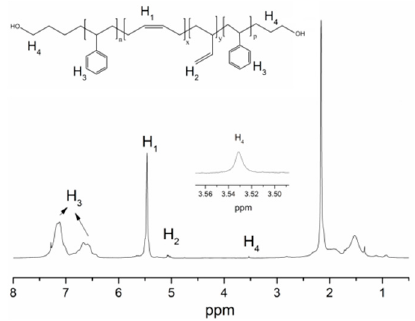
Figure 1. 1 H-NMR of HO–SBS–OH, initiator: St:B:St (molar ratio) =